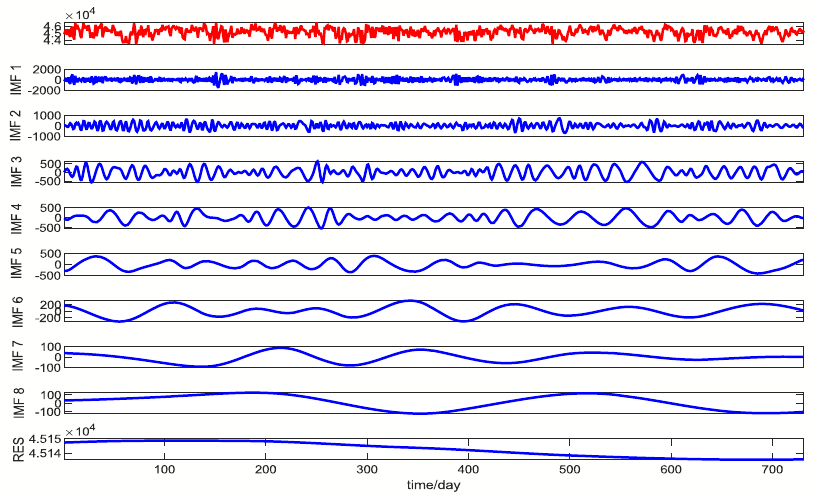
Figure 12. CEEMD decomposition to obtain modal components.